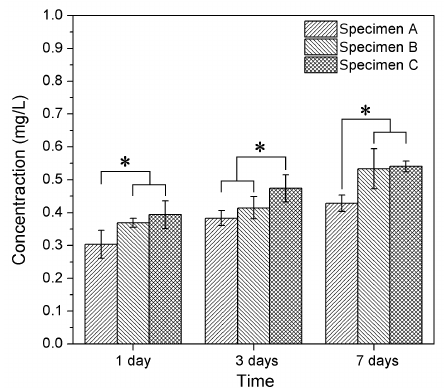
Figure 9. Cumulative concentrations of Ag ions released from chitosan composite coatings deposited on the nanotubular layer after 1, 3, and 7 days exposure in simulated body fluid (SBF) at 39 ◦ C. Data are presented as the mean ± SD ( n = 4). * p < 0.05; one-way ANOVA with Bonferroni post hoc correction.